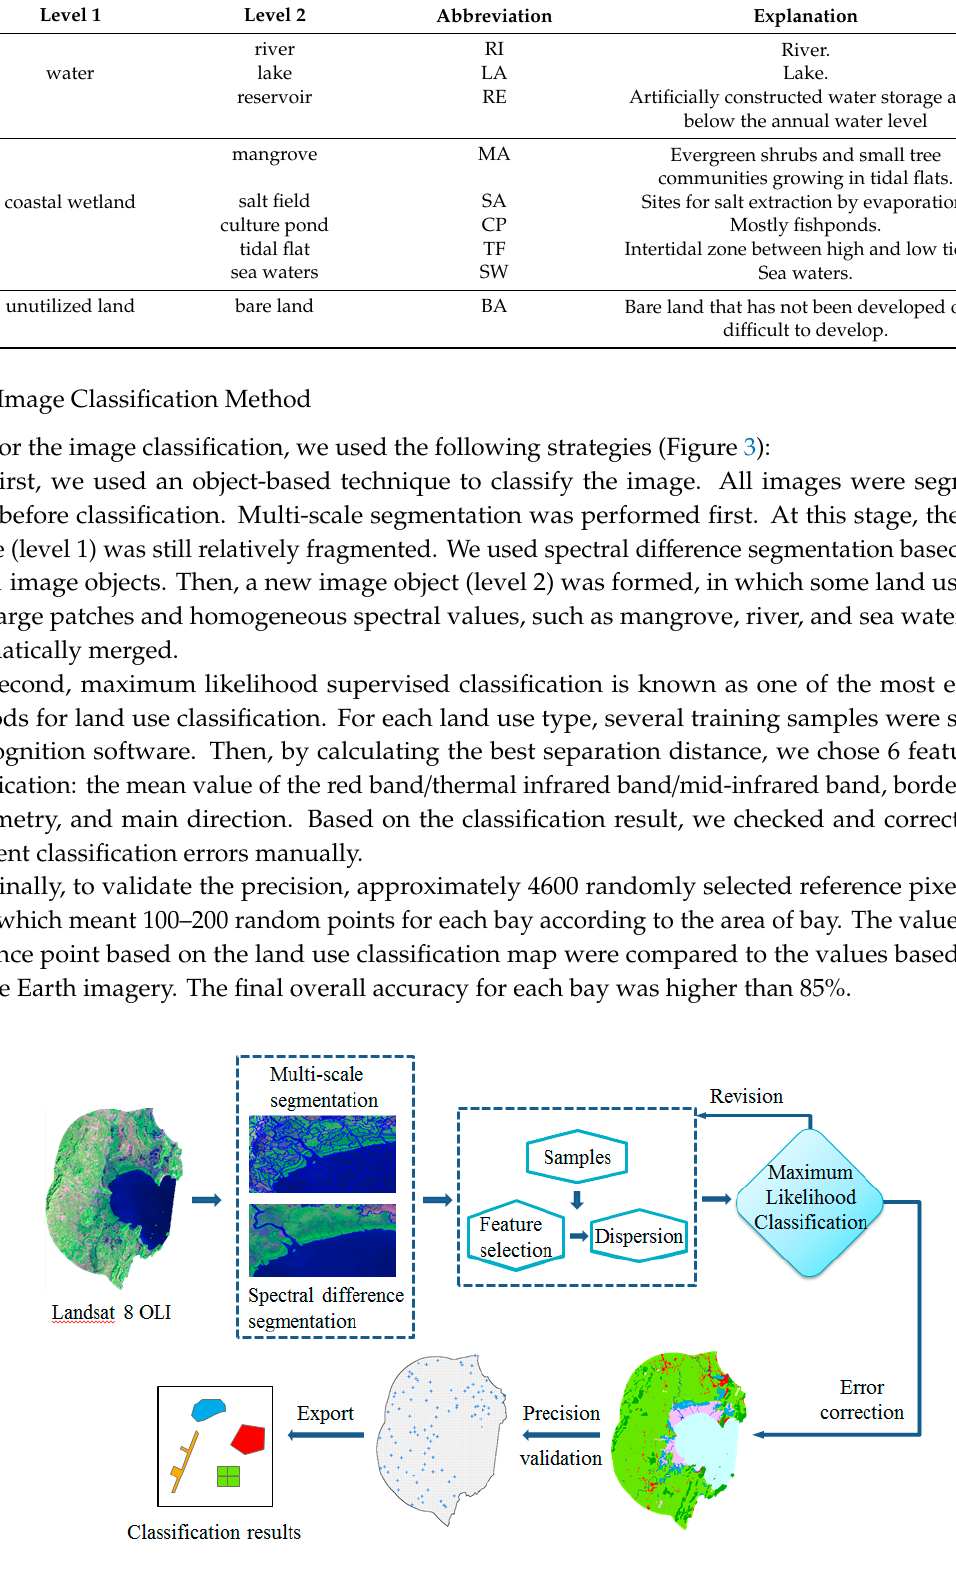
Figure 3. Classification flow chart.